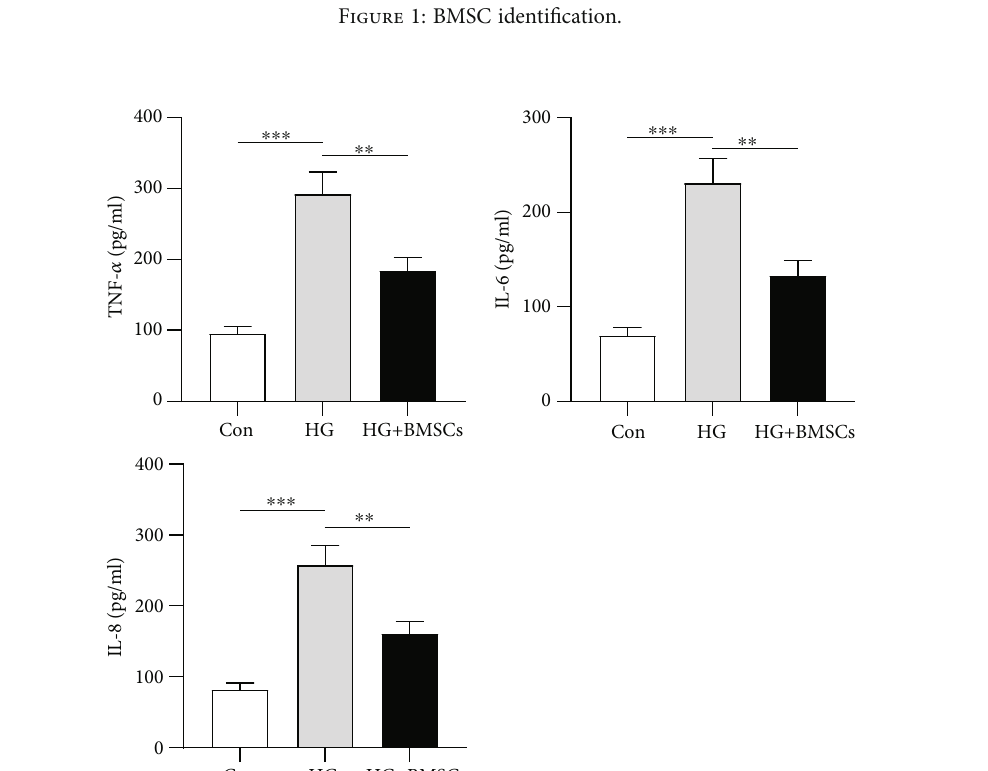
Figure 2: BMSCs alleviate in fl ammatory response of HG-treated HRMECs. (a) ELISA was carried out to evaluate the content of in fl ammation factors IL-8, IL-6, and TNF- α in HG-treated HRMECs after BMSC coculture. ∗∗ p < 0 : 01 and ∗∗∗ p < 0 : 001